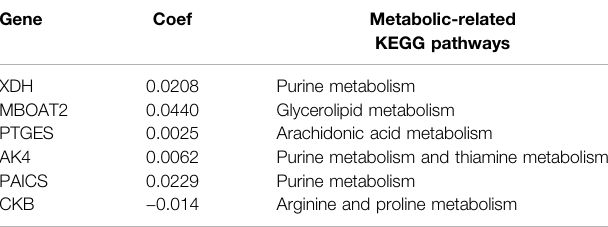
TABLE1| Metabolicriskscorewithrespecttothesixgenesdeveloped according to LASSO Cox regression analysis. Gene